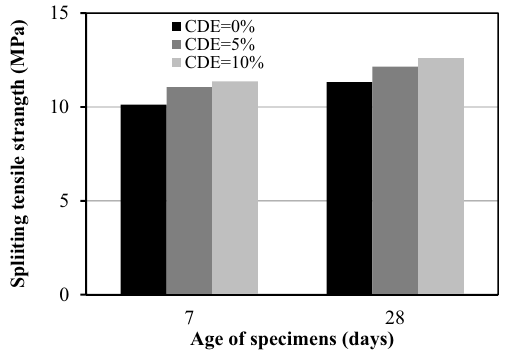
Figure 12: Splitting tensile strength of UHPC.